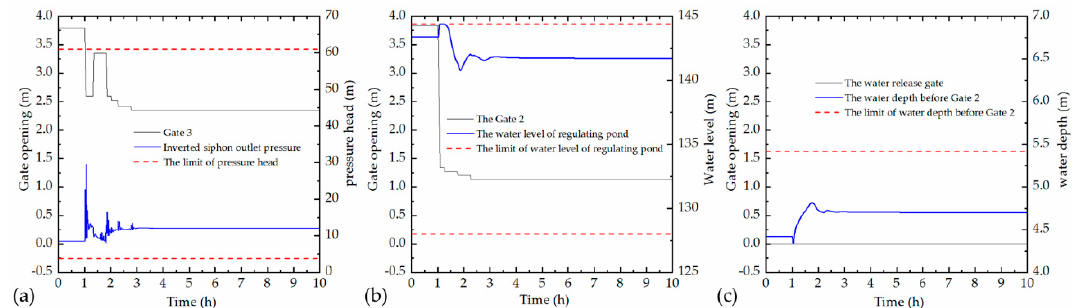
Figure 6. The simulation result of Scenario A with target flow of 30m 3 / s: ( a ) the trajectories of Gate 3 and the change of pressure at inverted siphon outlet; ( b ) the trajectories of Gate 2 and the change of water level in regulating pond; ( c ) the trajectories of the water release gate and the change of water depth before Gate